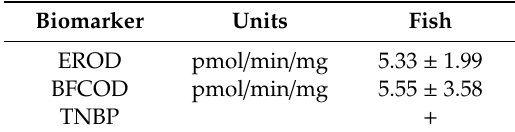
Table 1. Common carp hepatic S9 characterization biomarkers. Data are present as least squares mean ± SE, n = 12.